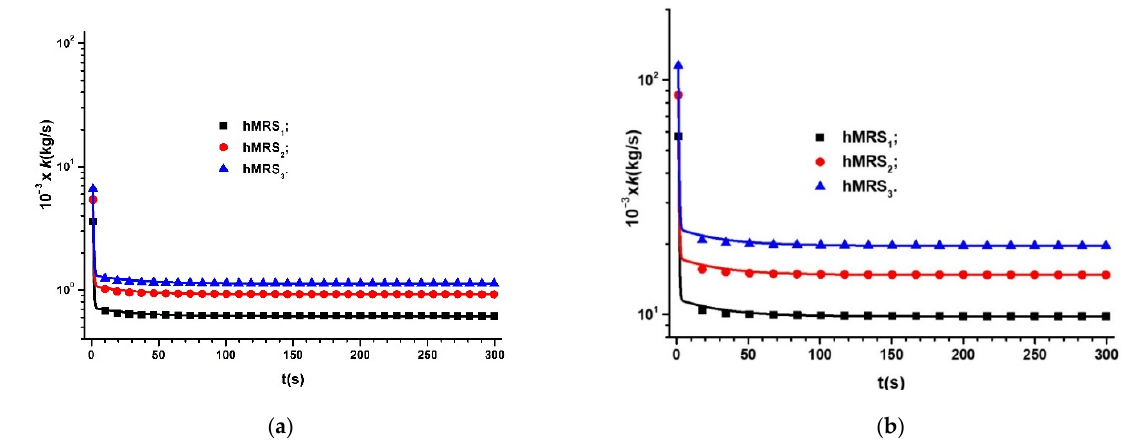
Figure 10. Time dependence of coupling coefficient k in hybrid hMRSs when MC capacitors are placed in a static magnetic field superimposed over a gravitational field: ( a ) B = 0.10 T; ( b ) B = 0.4 T.